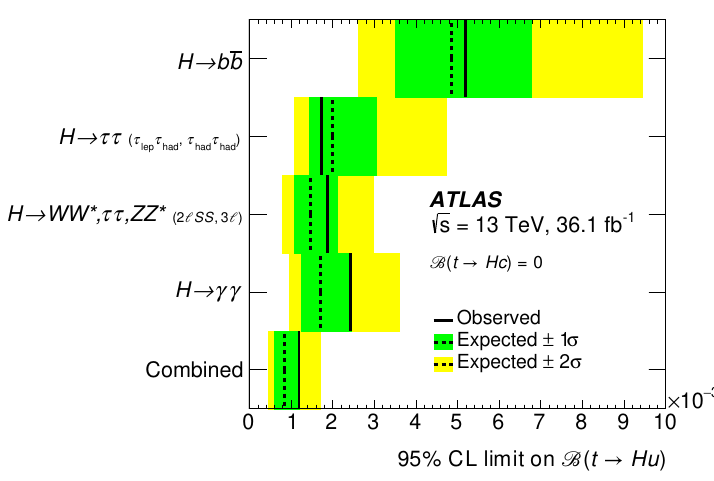
Figure 14 . 95% CL upper limits on B ( t ! Hu ) for the individual searches as well as their combination, assuming B ( t ! Hc ) = 0. The observed limits (solid lines) are compared with the expected (median) limits under the background-only hypothesis (dotted lines). The surrounding shaded bands correspond to the 68% and 95% CL intervals around the expected limits, denoted by (cid:6) 1 (cid:27) and (cid:6) 2 (cid:27) , respectively.